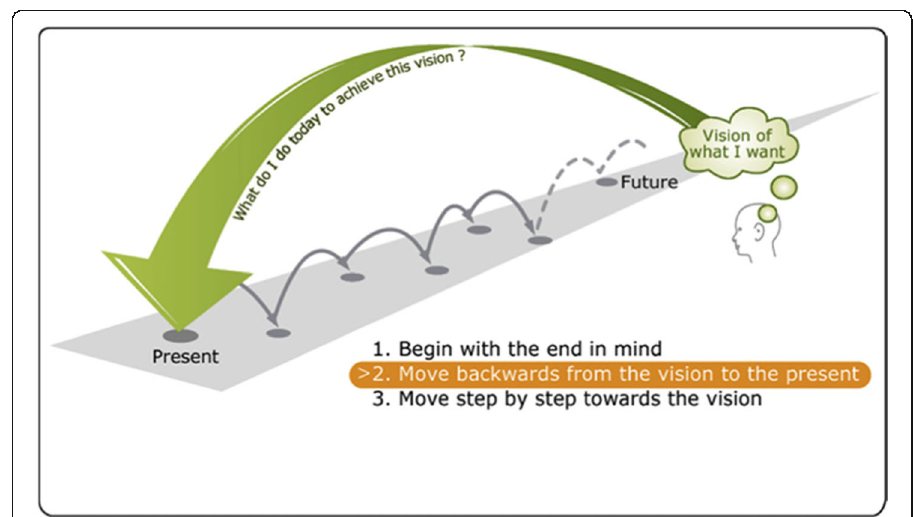
Fig. 1 The backcasting process from the Natural Step. Source: Holmberg